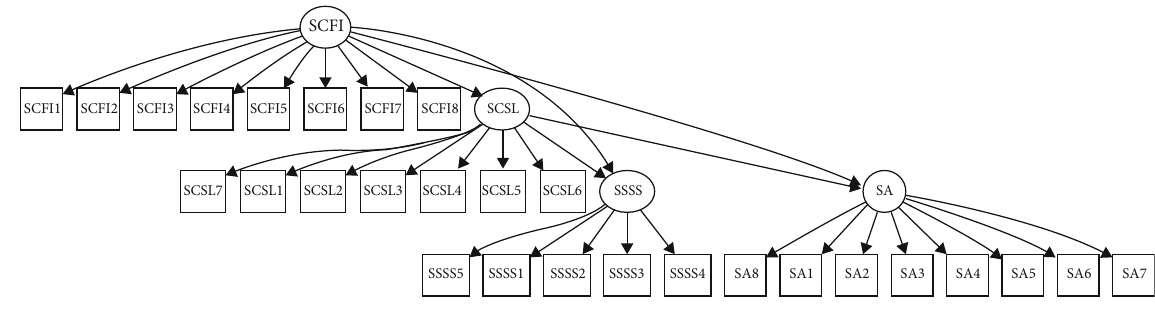
Figure 1: Research model.